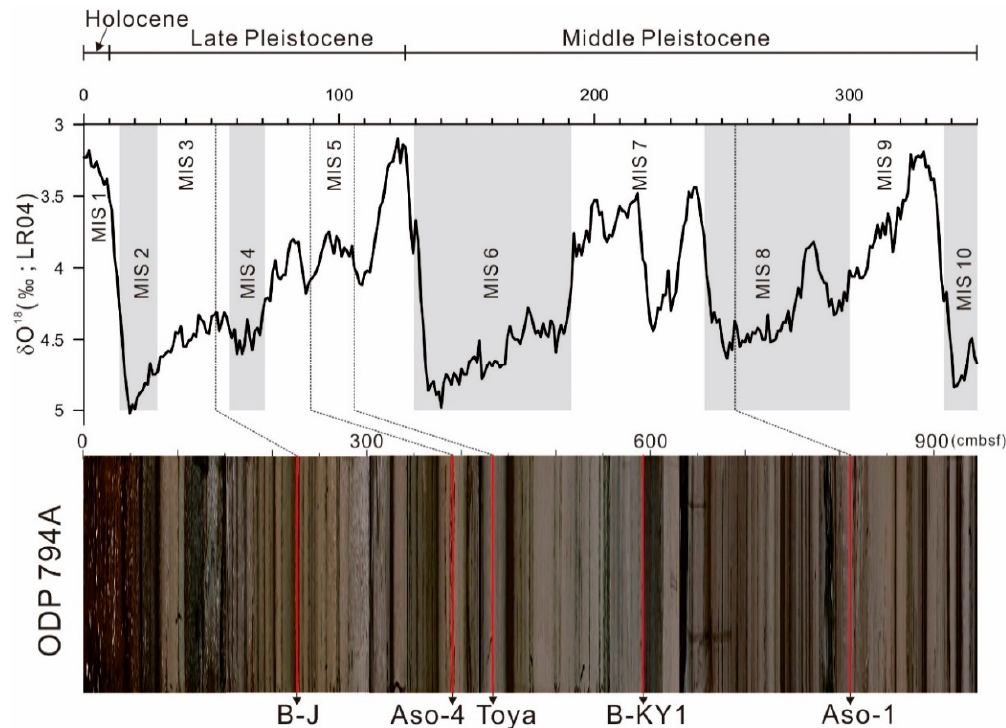
Figure 3. Stratigraphic position of the B-KY1 tephra layer between the Toya and Aso-1 tephra layers in the ODP 794A core (Photographs adapted from [41]).